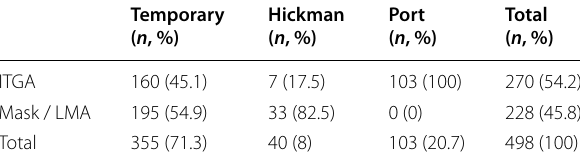
Abbreviations : ITGA Intratracheal general anesthesia, LMA Laryngeal mask. Data are given as numbers ( n ) and percentages (%)